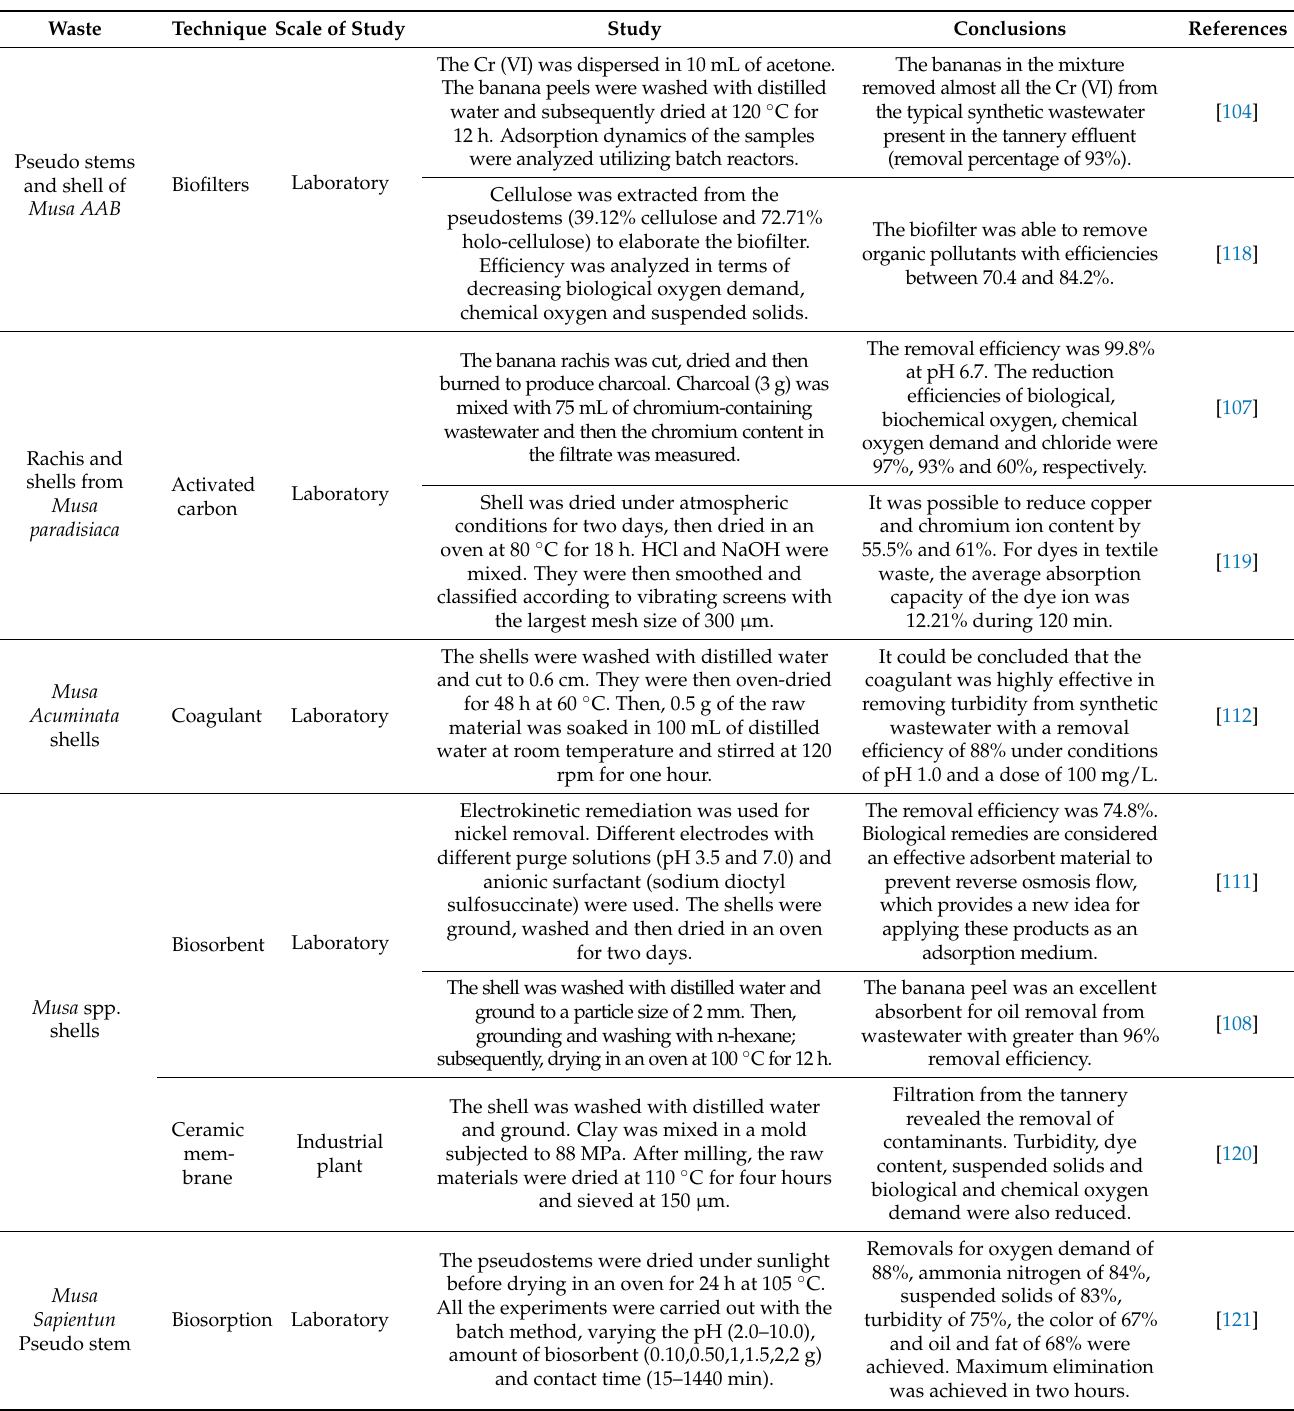
Table 7. Studies on wastewater treatment using banana